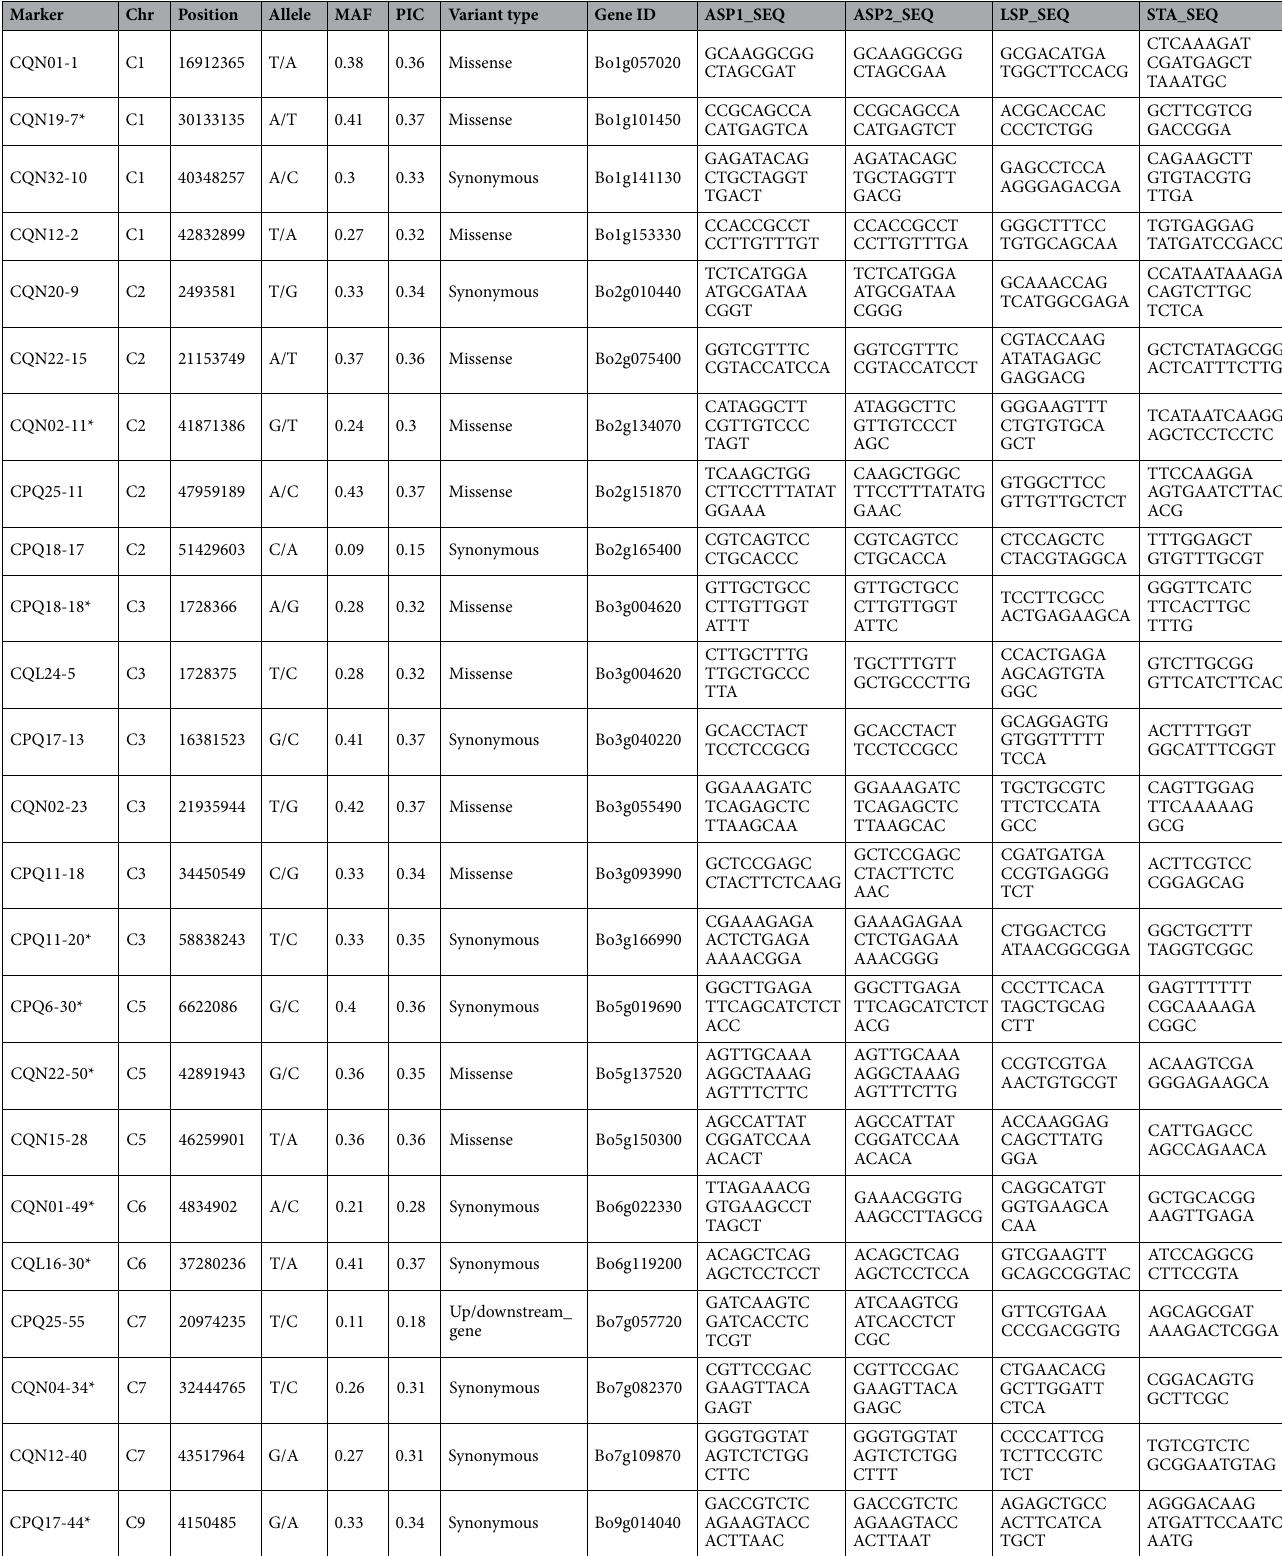
Table 4. Twenty-four core markers used for Fluidigm assay. *Asterisk indicates F10 core markers. Chr, chromosome; PIC, polymorphic information